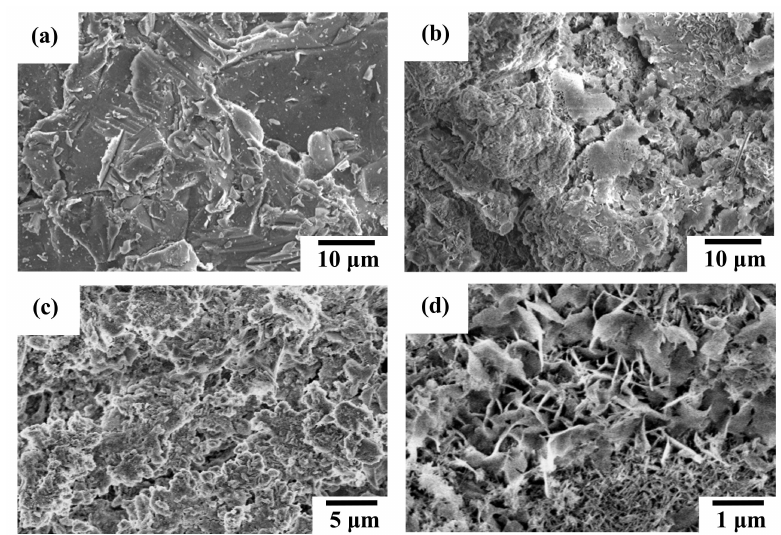
Figure 4. SEM surface morphologies of the ( a ) grit-blasted AZ91D substrate, ( b ) alkaline pre-treated